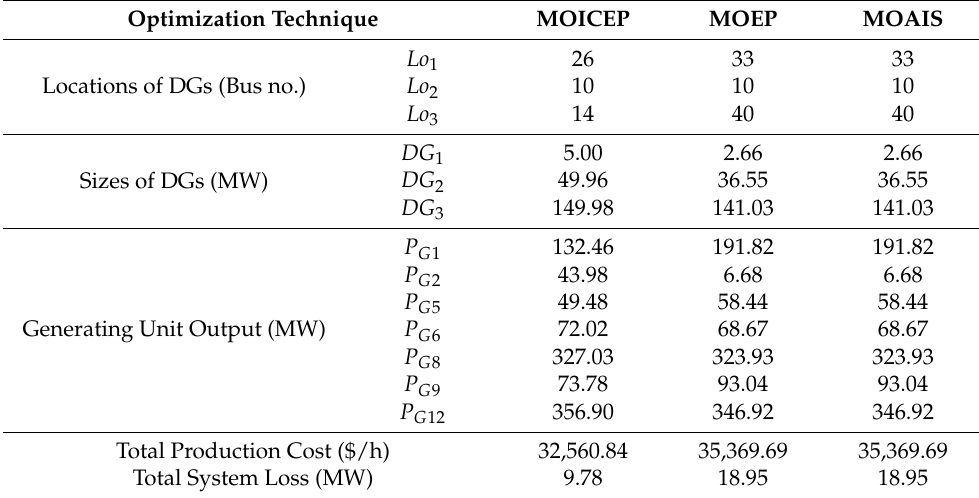
Table 17. Results of the integrated ED problem with a valve-point loading effect and DG installation of the IEEE 57-Bus RTS ( w 1 = 0.9 and w 2 = 0.1). Optimization Technique MOICEP MOEP MOAIS Lo 1 Locations of DGs (Bus no.)